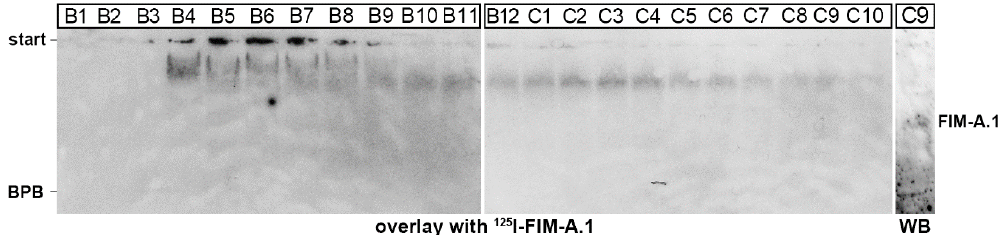
Figure 5. In vitro binding of 125 I-labeled FIM-A.1 with mucin fractions from X. laevis skin (overlay assay). FIM-A.1 was purified from X. laevis skin via SEC (from Figure 2) followed by anion-exchange chromatography of fractions D4 + D5 (see Figure 4A). Then, fraction B11 containing purified FIM-A.1 (Figure 4A) was labeled with 125 I. 1% AgGE of fractions B1–C10 after SEC from Figure 2 and hybridization of the blot with 125 I-FIM-A.1 (autoradiography). The start and the dye bromophenol blue (BPB) are marked on the left. For comparison, FIM-A.1 was detected on the same blot by immunostaining with anti-FIMA-1 (WB, Western blot; C9).